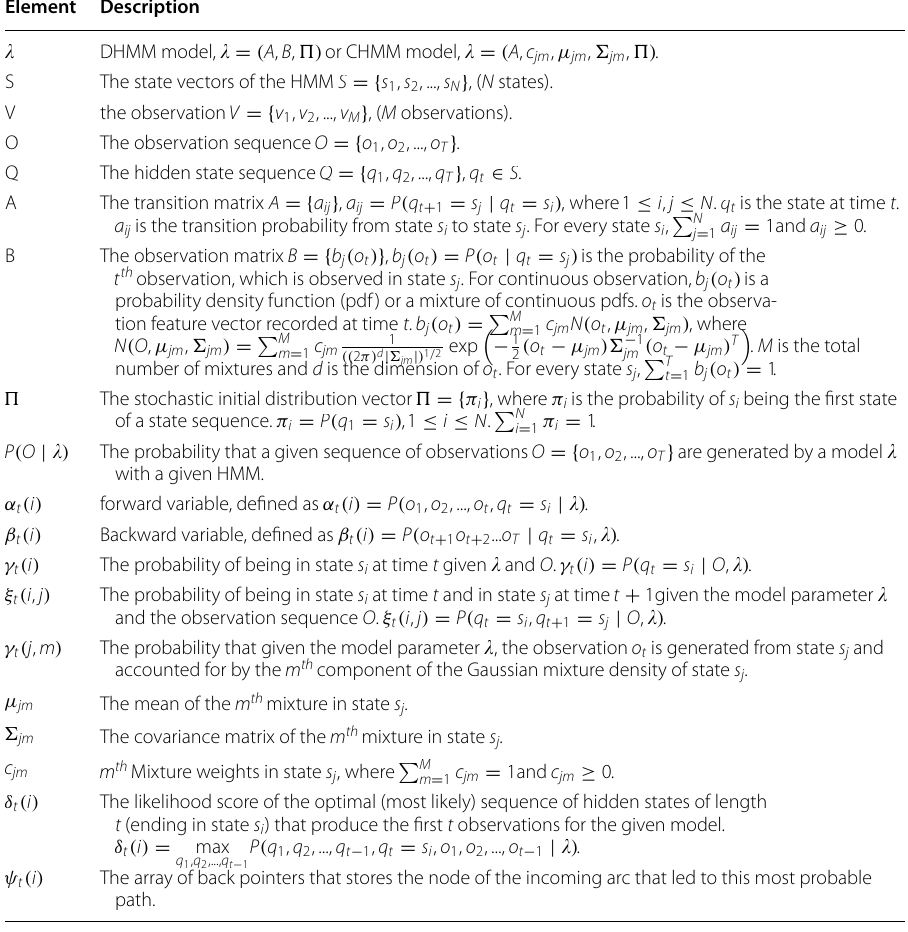
Table 1 Explanation of the elements of an HMM Element